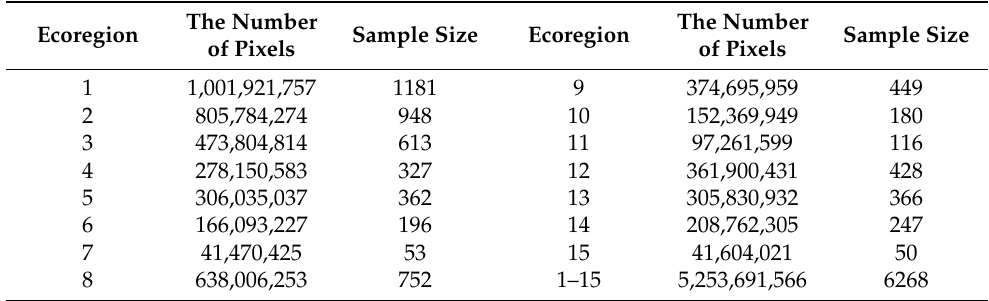
17 of 25 The Number of Pixels